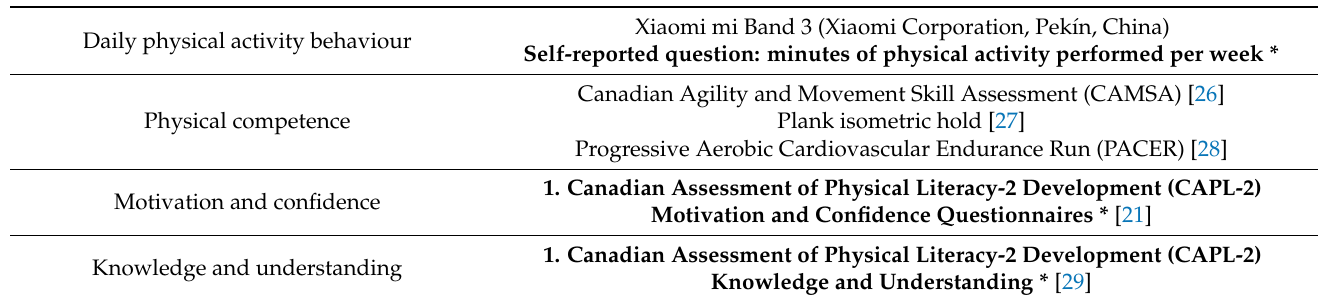
Table 1. Tests that make up the Canadian Assessment of Physical Literacy-2 Development (CAPL-2) [21]. Daily physical activity